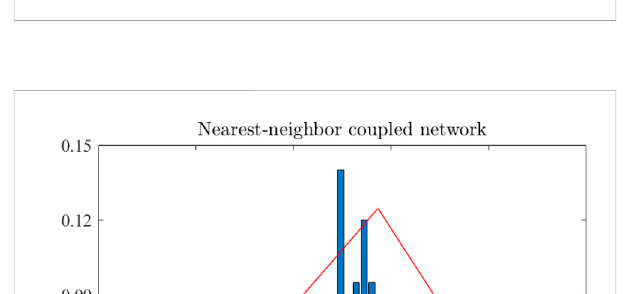
FIGURE 3 Eigenvalue histograms of C and its triangular approximations for a globally coupled network.